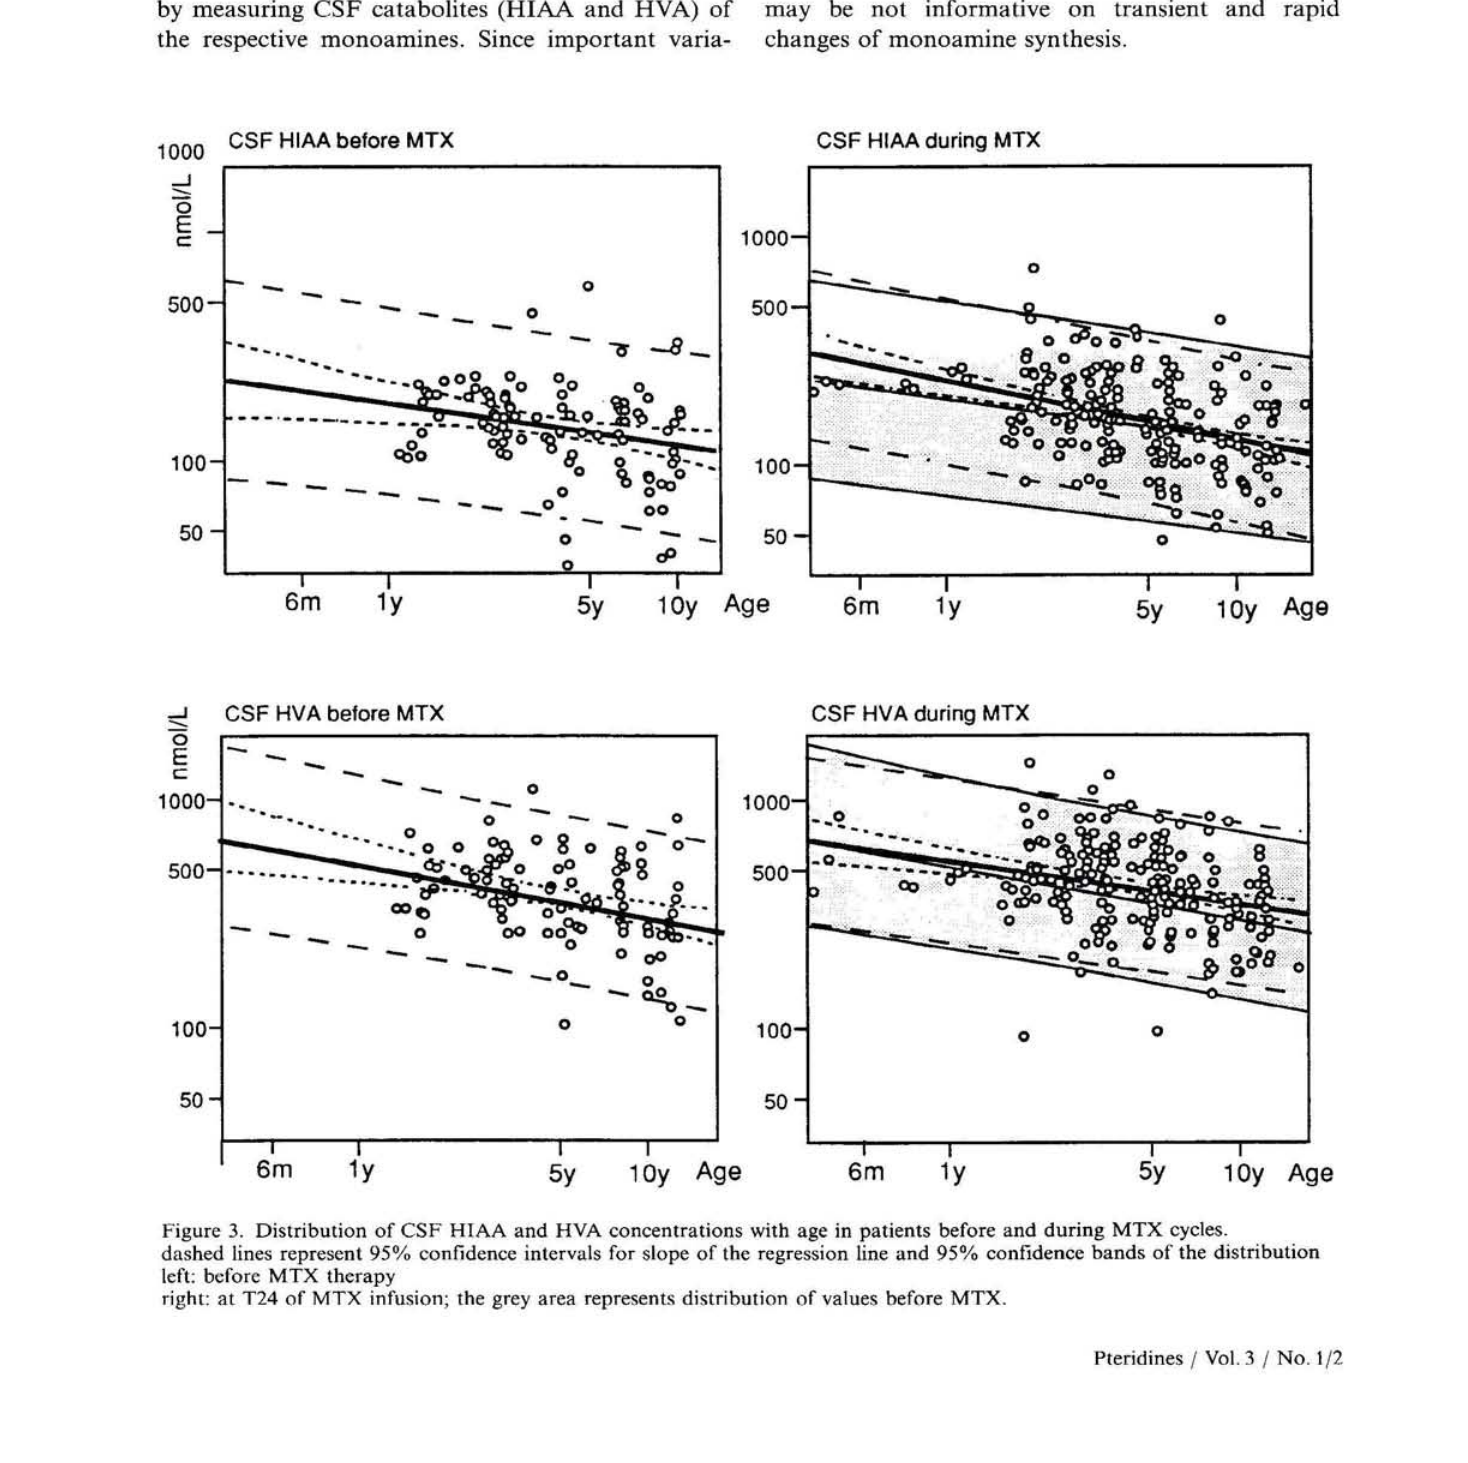
Pteridines / Vol.3 / No.